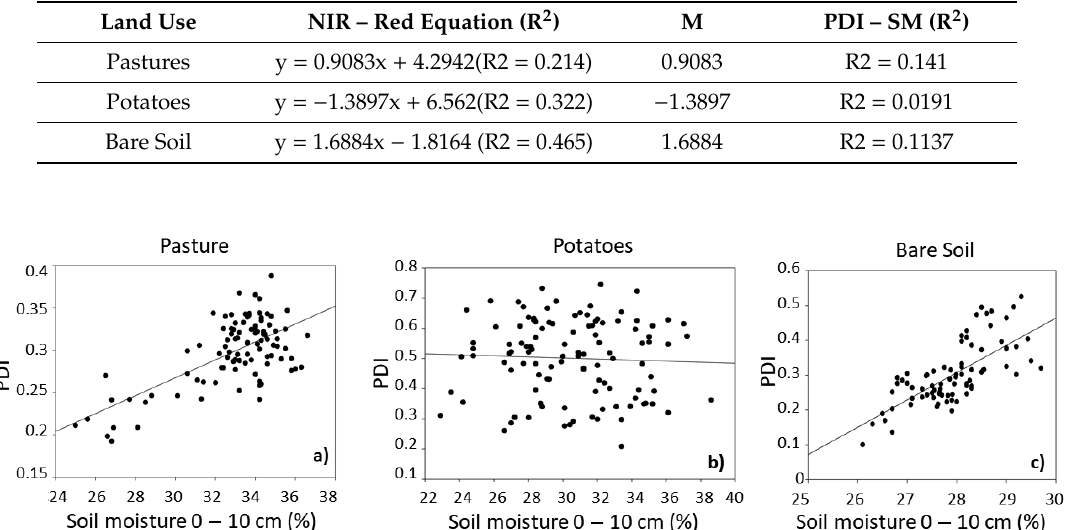
Table 3. NIR– Red linear equations to obtain the M value to calculate the PDI at 300 cm spatial resolution.